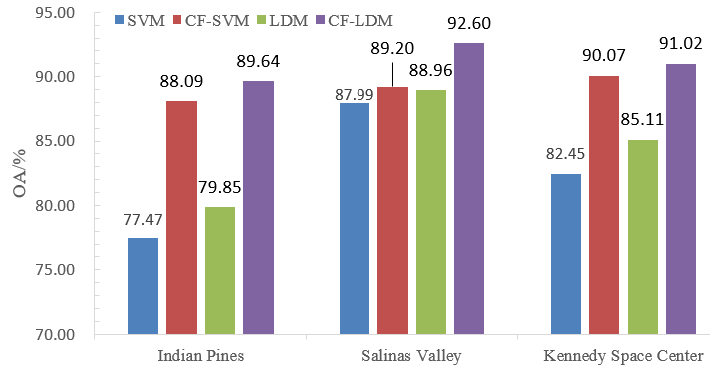
Figure 12. Comparison of SVM, CF-SVM, LDM and CF-LDM on three datasets.